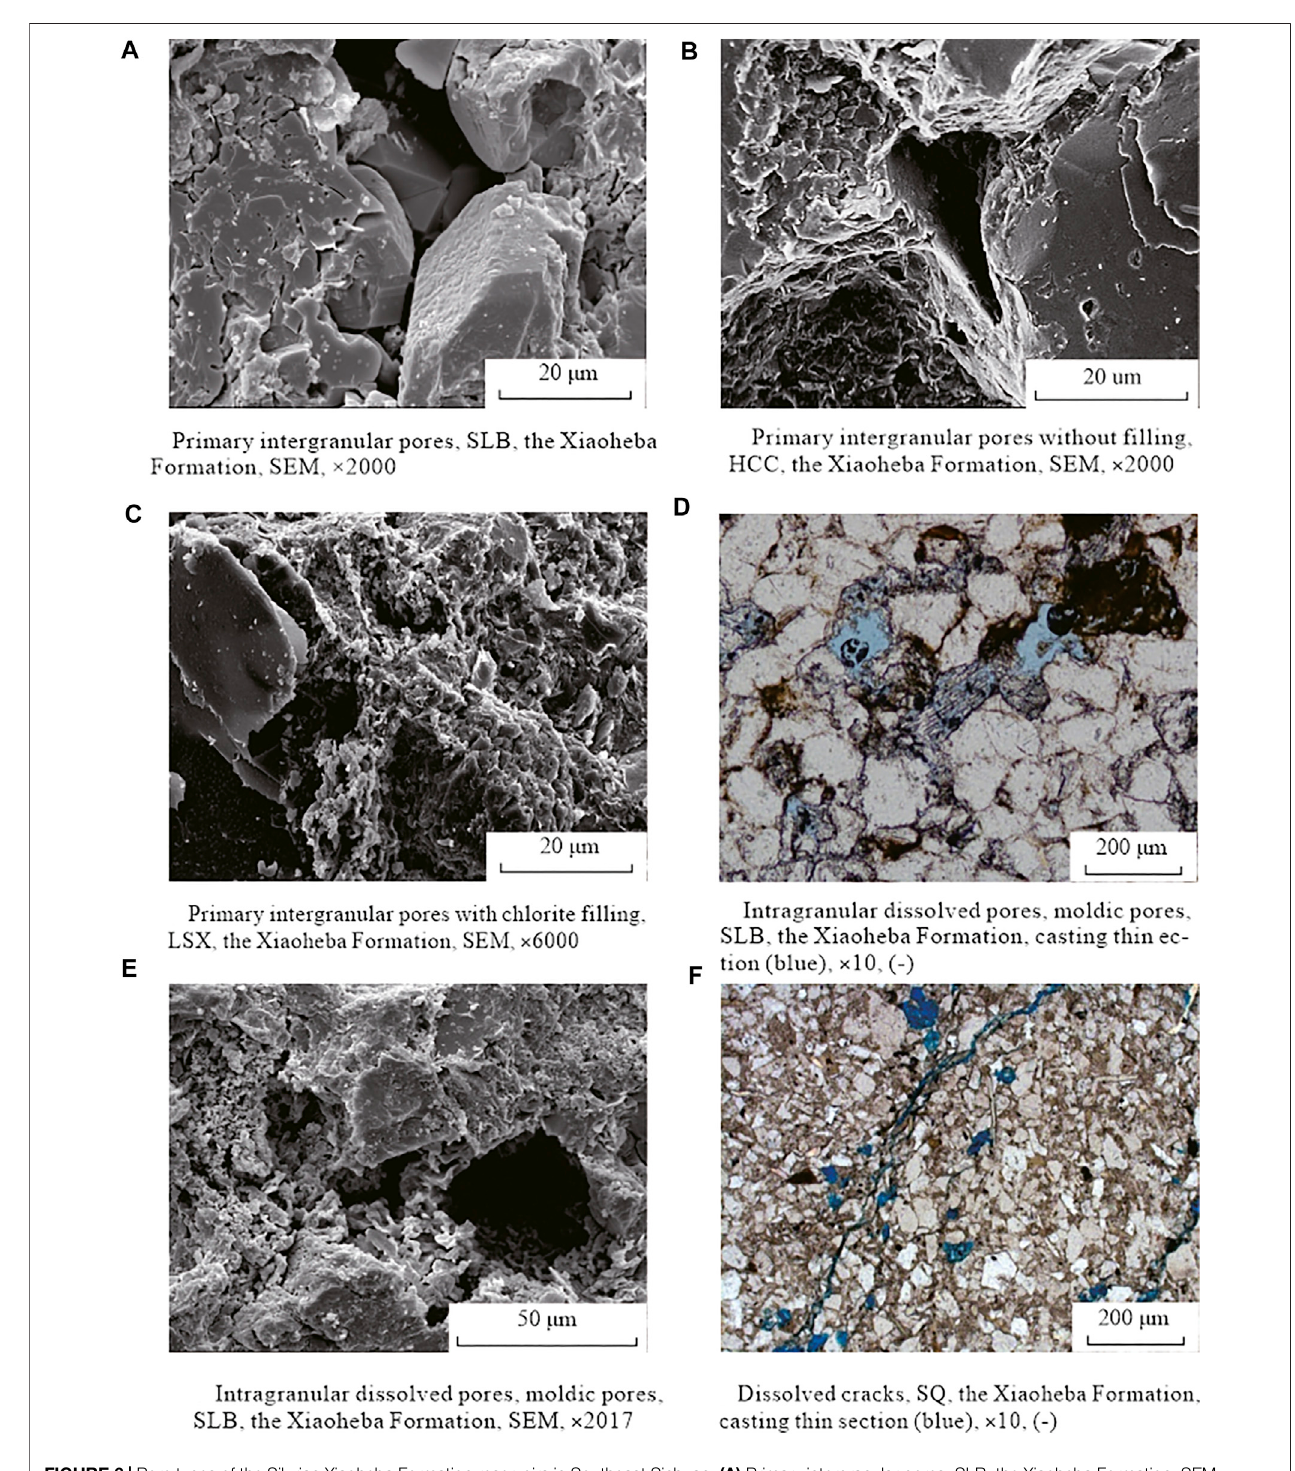
FIGURE 6 | Pore types of the Silurian Xiaoheba Formation reservoirs in Southeast Sichuan. (A) Primary intergranular pores, SLB, the Xiaoheba Formation, SEM, ×2000; (B) Primary intergranular pores without fi lling, HCC, the Xiaoheba Formation, SEM, ×2000; (C) Feldspar dissolved pores, SLB, the Xiaoheba Formation, SEM, ×2000; (D) Intragranular dissolved pores, moldic pores, SLB, the Xiaoheba Formation, casting thin section (blue), ×10, ( − ); (E) Intragranular dissolved pores, moldic pores, SLB, the Xiaoheba Formation, SEM, ×2000; (F) Dissolved cracks, SQ, the Xiaoheba Formation, casting thin section (blue), ×10, ( − )